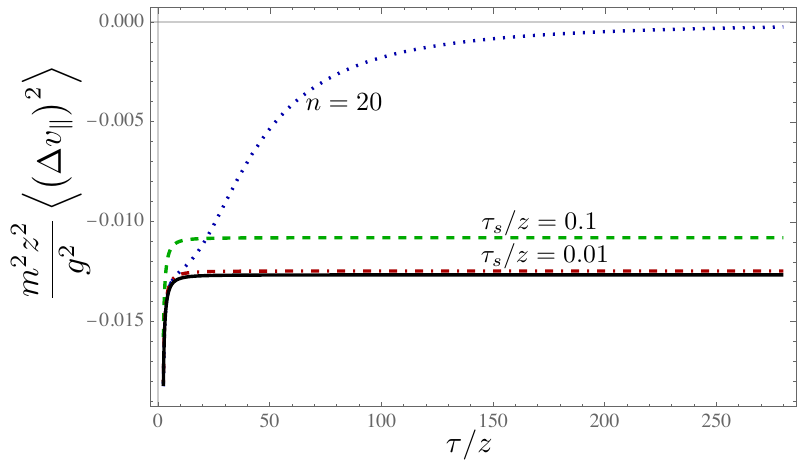
Figure 5 . Late time behavior of the dispersion of parallel component of the particle velocity when the switching F ( n ) (cid:28) ( t ) is implemented (dotted curve), and when the alternative switching F (cid:28) is implemented (dashed and dot-dashed curves). The solid curve describes the sudden